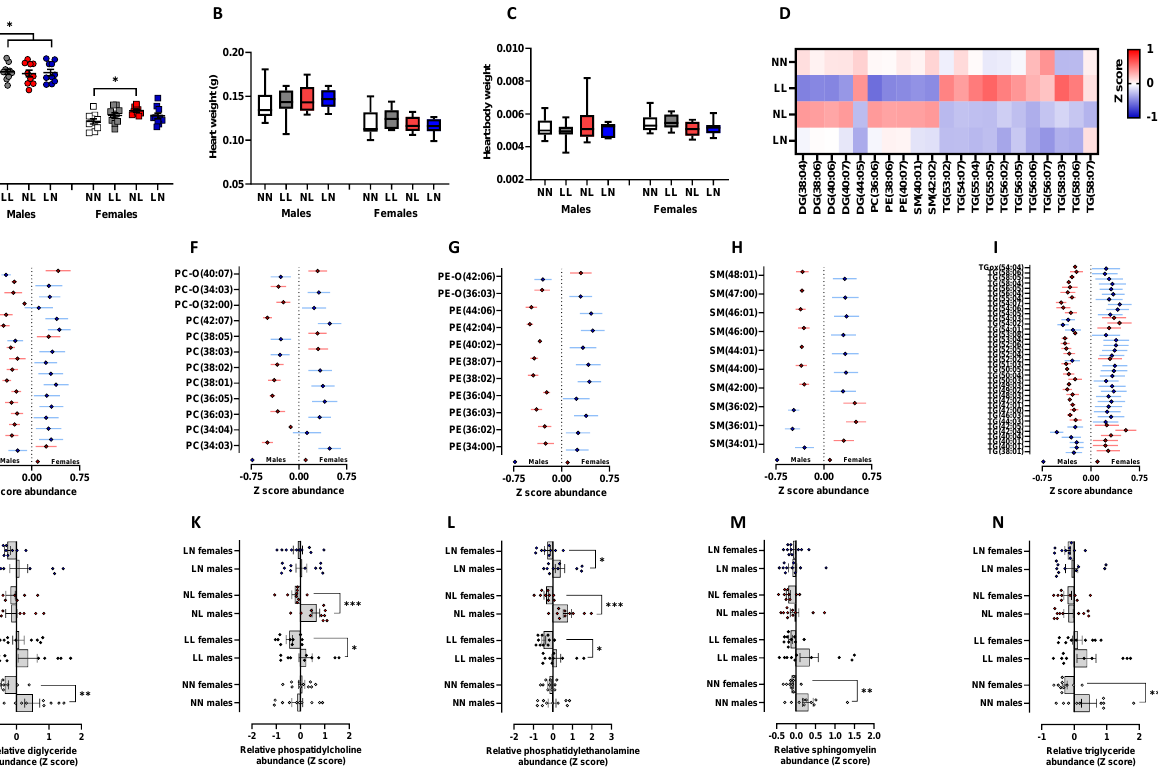
Figure 3. Impact of paternal diet on F1 adult offspring heart tissue lipid profiles: ( A ) the body weight, ( B ) heart weight and ( C ) heart:body weight ratio of NN (NPD sperm and LPD seminal plasma), LL (LPD sperm and LPD seminal plasma), NL (NPD sperm and LPD seminal plasma) and LN (LPD sperm and NPD seminal plasma) offspring at 16 weeks of age. ( D ) Z scores of differential lipids between NN, LL, NL and LN offspring hearts. Sex-specific differences in cardiac ( E ) diglycerides (DG; water-loss product from fragmentation in source), ( F ) phosphatidylcholine (PC), ( G) phosphatidylethanolamines (PE), ( H ) sphingomyelins (SM) and ( I ) triglycerides (TG) between male and female offspring. Sex-specific differences separated by dietary treatment group for ( J ) diglycerides (DG; water-loss product from fragmentation in source), ( K ) phosphatidylcholine (PC), ( L ) phosphatidylethanolamines (PE), ( M ) sphingomyelins (SM) and ( N ) triglycerides (TG). N = 20 offspring (10 males and females) per treatment group, sampled from all litters generated. Data are expressed as mean ± SEM ( A , B , D – M ). * p < 0.05, ** p < 0.01, *** p < 0.001. Statistical differences were determined using a random effects regression analysis ( A , B ), one-way ANOVA with Bonferroni post hoc correction ( C ) or Student ’s t -test ( D – M ).